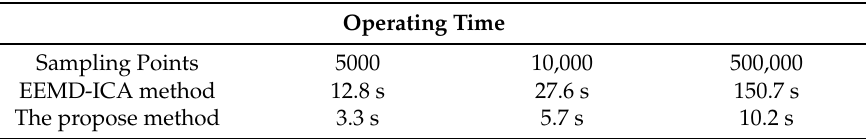
Figure 15. Spectrum of the separated noisy signals by the proposed method: ( a ) Spectrum of the outer-race defect; ( b ) Spectrum of the roller defect. Table 2. Operating time.